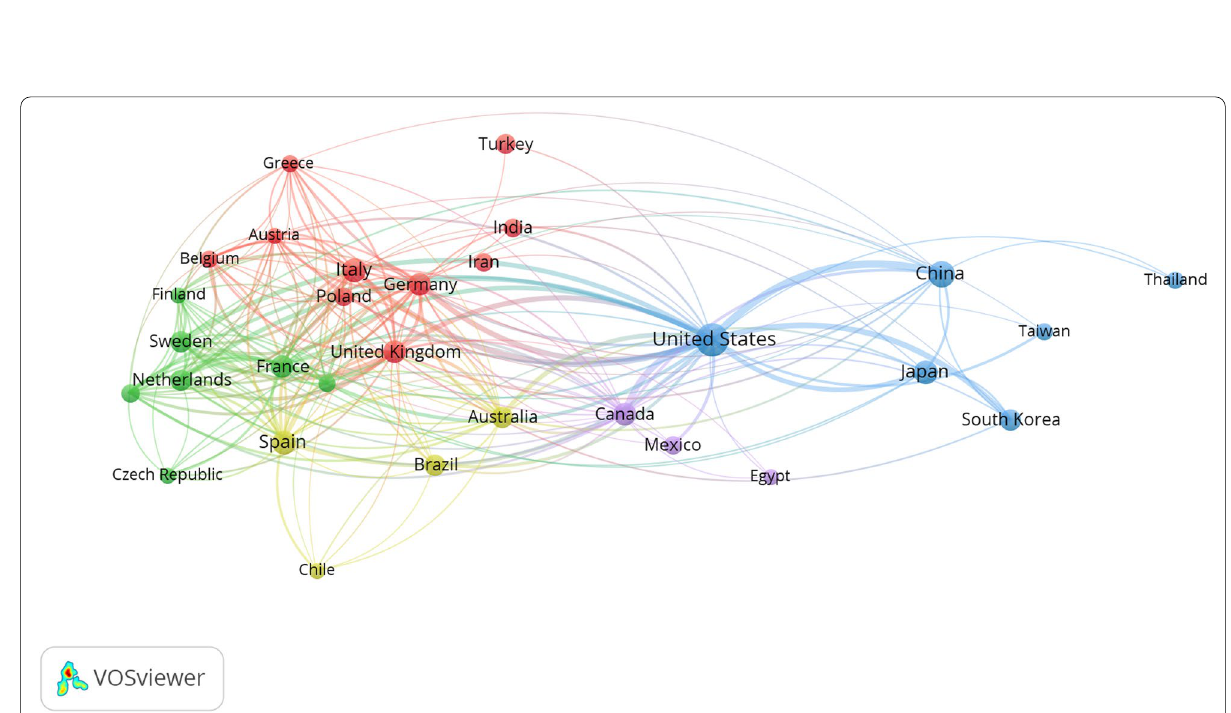
Fig. 4 Network visualization map of international research collaboration between countries with a minimum research output of 50 documents ( n 30 countries) on insulin resistance and obesity. The map was created using VOSviewer software version =